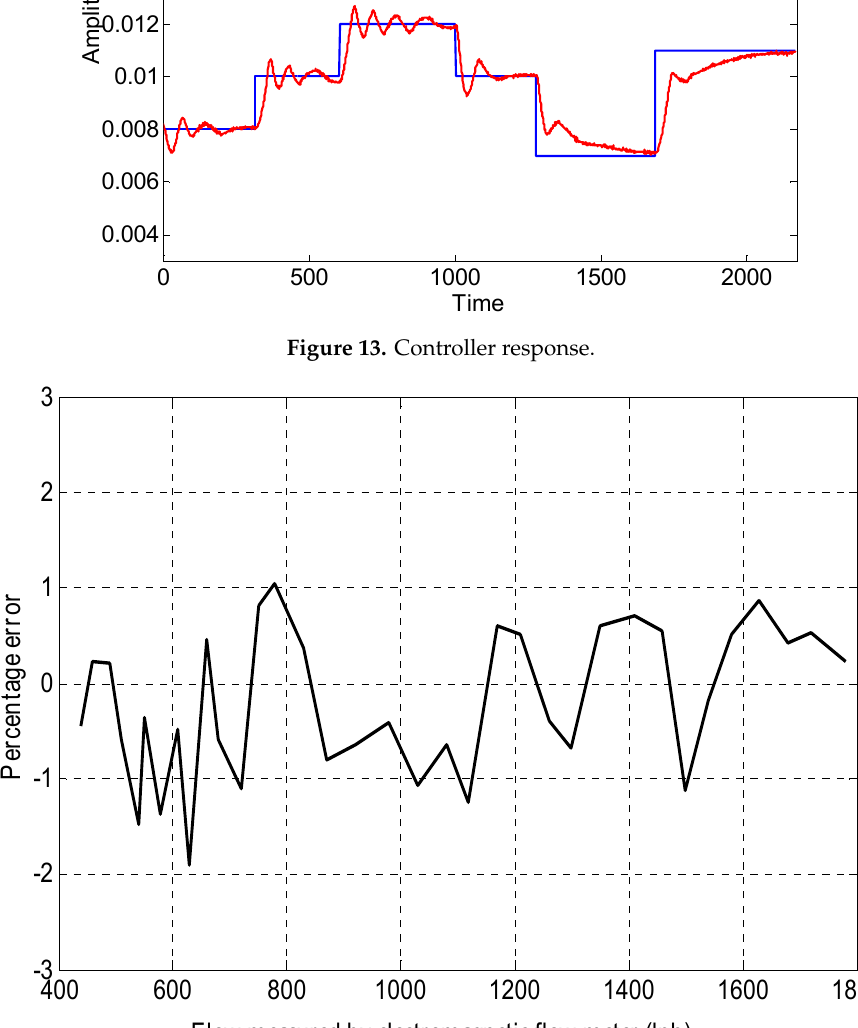
Figure 14. Error characteristics of the proposed technique.